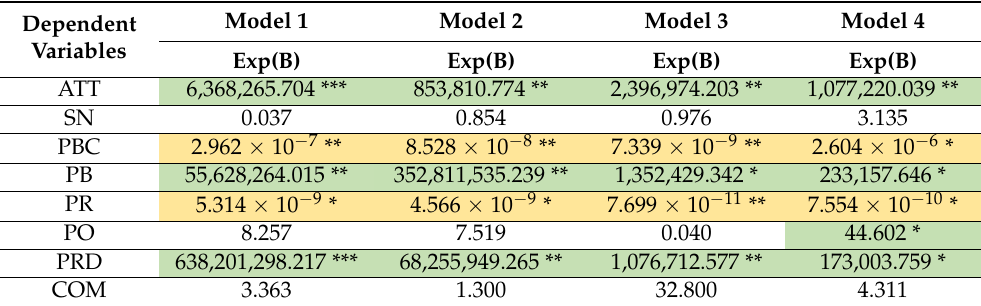
Table 5. The marginal effect results of factors influencing people’s decision to participate in urban agriculture (the reference category is group 5